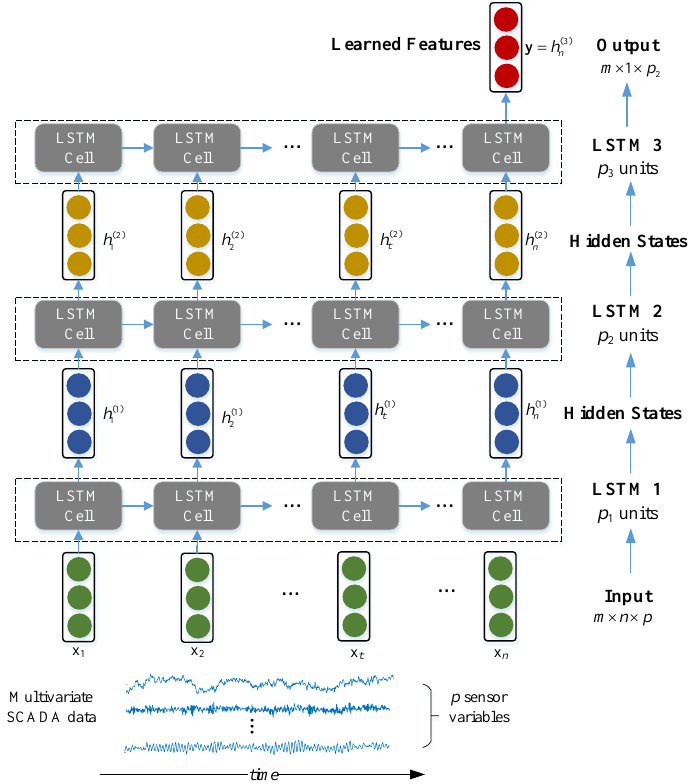
Figure 3. A three-layer deep LSTM architecture for temporal feature learning with multivariate time series. Here, p 1 , p 2 , p 3 denote the number of units for three LSTM